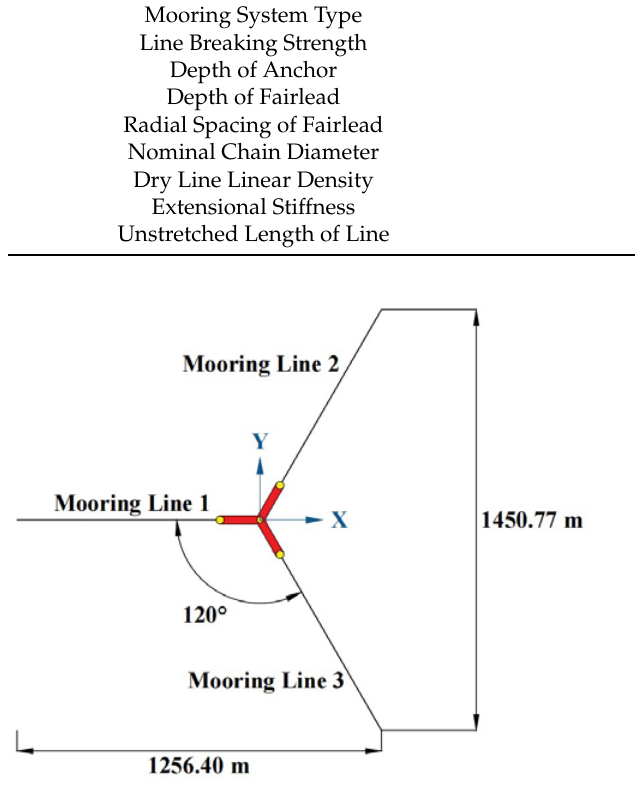
Figure 3. Arrangement of the mooring system.